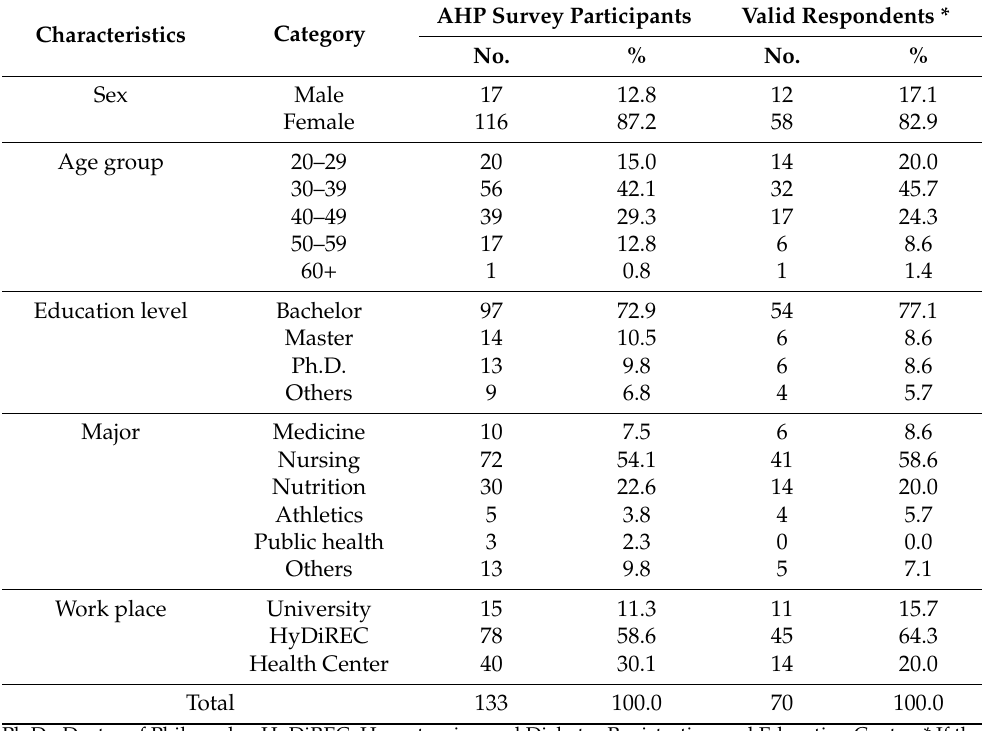
Table 1. General characteristics of analytic hierarchy process (AHP) survey participants. Unit: Person